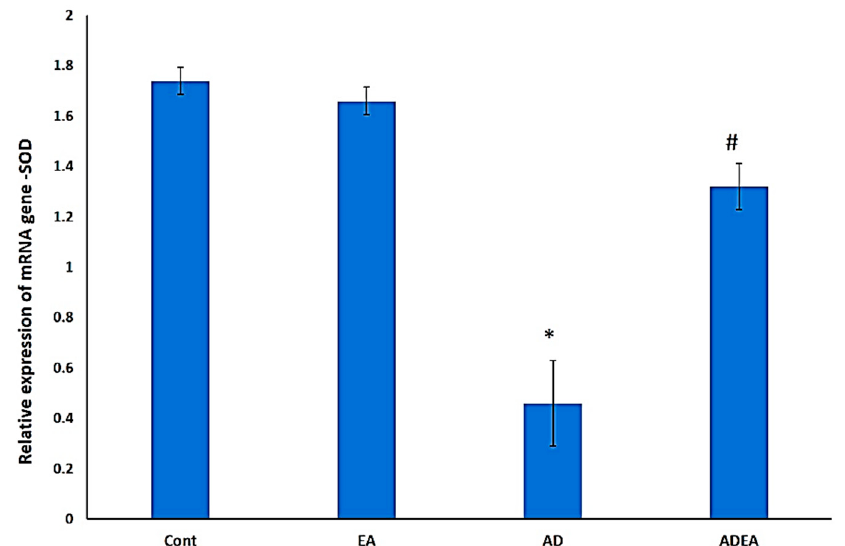
Figure 7. Bar graph showing the relative expression of SOD mRNA in ERC. One-way ANOVA was used, and Fisher’s LSD t -test was applied when equal variance could be assumed. * Significantly different from the control, EA, and ADEA groups at p ≤ 0.05. # Significantly different from the AD group at p ≤ 0.05.